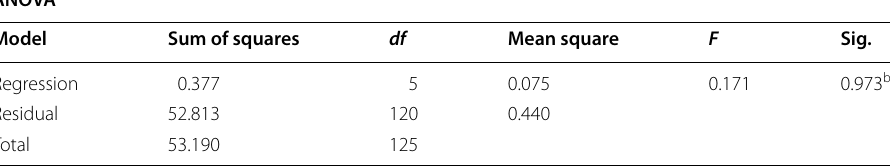
Table 5 Heteroscedasticity